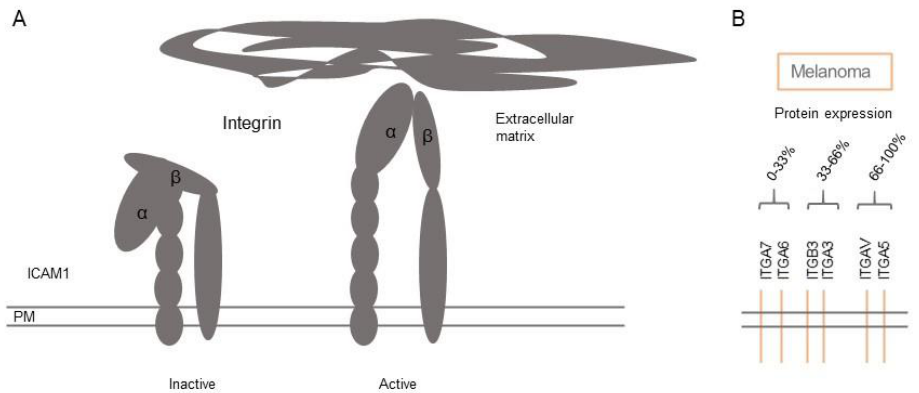
Figure 3. Schematic structure of integrins and protein expression in melanoma. ( A ) Extracellular structure of the ICAM 1 as an example for the integrin family. ( B ) Integrin protein expression on melanoma cells obtained from the Human Protein Atlas (immunohistochemistry staining). Staining intensities are estimated based on the percentage of patient samples positively stained for the respective CAM and classified into low (0 – 33% of patients), medium (33 – 66% of patients), and high expression (66 – 100% of patients). See also Table S2.